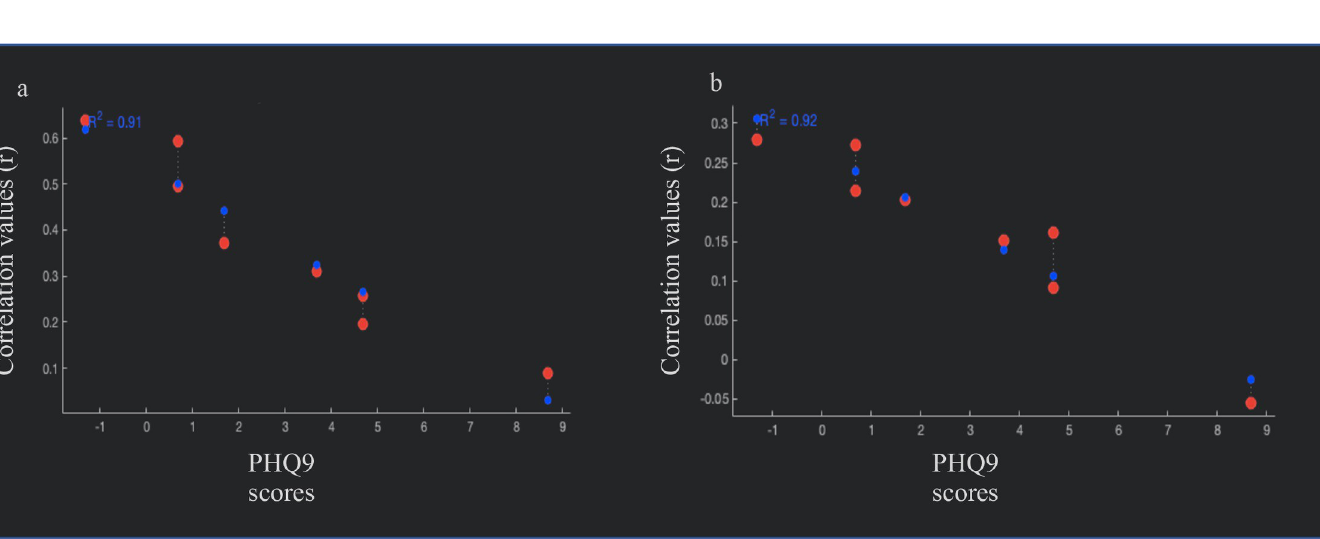
PLOS ONE | https://doi.org/10.1371/journal.pone.0253261 June 17,